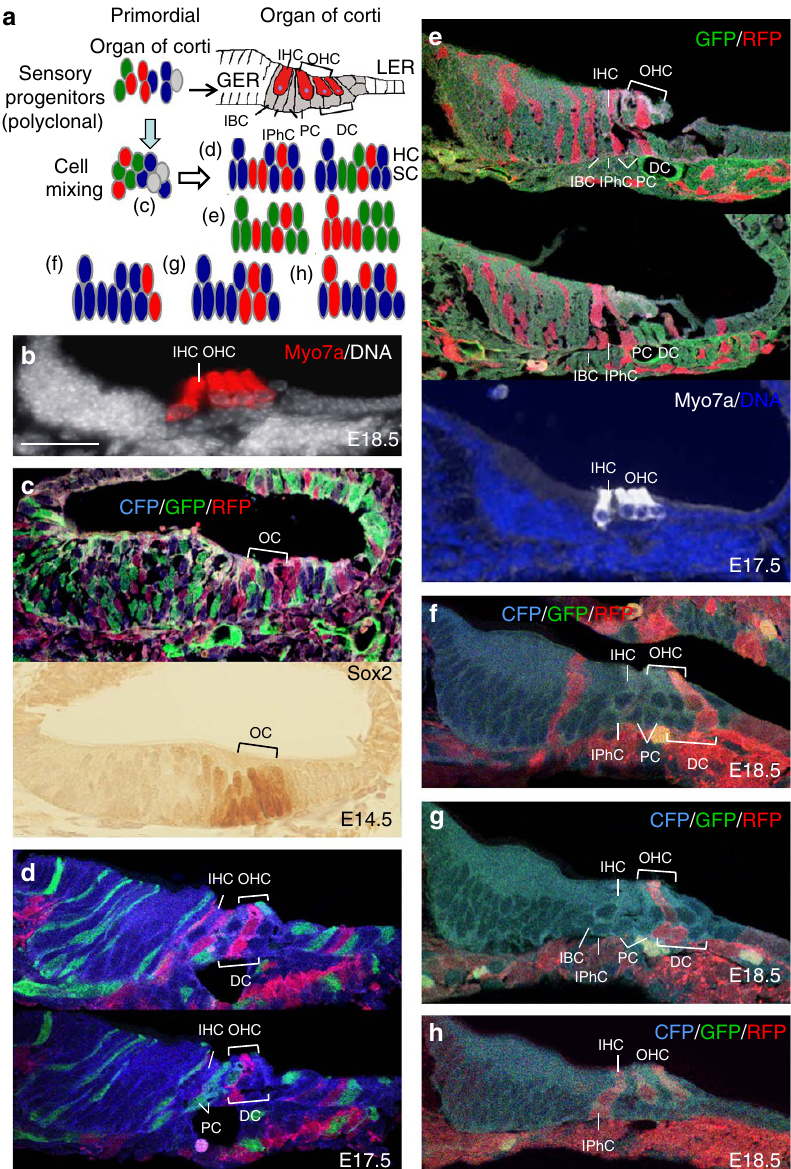
Figure 2 | Clonal analysis of tetrachimeric cochlea between E14.5 and E18.5. ( a ) Schematic of expected results of cochlear sensory organ obtained in this study. Cell types in the organ of Corti (OC): one inner hair (IHC) and three outer hair (OHC) cells are surrounded by different types of supporting cells (SC): one inner border cell (IBC), one inner phalangeal cell (IPhC); inner and outer pillar cells (PC); and three Deiters’ cells (DC). In the case where multiple putative bipotent progenitors proliferate in the prosensory domain and mix during development, it would always show a mixture of the same colour as observed in ( c ). Within the OC, if a progenitor differentiates into hair and underlying SCs, then these cells next to each other would show the same colour as indicated in ( d – h ), which illustrate the results observed in ( d – h ). ( b ) A section of E18.5 cochlea stained with Hoechst (grey) and anti-Myo7a (red). ( c ) Upper panel: Merged image of a section of chimeric cochlea at E14.5. Lower panel: an adjacent section immunostained for Sox2 in the nascent OC. ( d ) Merged images from adjacent sections of four-coloured (CFP, GFP, RFP and nonfluorescent) cochlea at E17.5. ( e ) Top panel: Merged image of a section showing GFP, RFP and nonfluorescent cochlea at E17.5. Middle panel: A merged confocal image from adjacent section showing the IHC and the IB, IPhC and PCs in red but the three OHCs and the DCs in green. Bottom panel: an adjacent section stained with anti-Myo7a (white) and Hoechst (blue). ( f ) Merged image of a section of E18.5 cochlea (injected with reduced coloured ES cells) showing the outermost OHC and underlying DC in red, while the other two OHCs and the IHC as well as other SCs uncoloured. ( g ) Merged image from a section of another cochlea of the same embryo as shown in ( e ). The middle OHC and two underlying SCs are displayed in red. ( h ) Merged image from an adjacent section of F showing the IHC and the IPhCs in red. Two red OHCs are separated by the uncoloured OHC. Scale bar: 25 m m ( b ); 50 m m ( c – g We next co-injected the mitotic tracer 5-ethynyl-2 0 - exit in an apex-to-base progression between E12.5 and deoxyurindine (EdU) with tamoxifen (2 mg) to confirm that E14.5, EdU-Alexa 350/488 antibody staining of cochlea at E18.5 marked individual cells within each single-colour clonal cluster ( n ¼ 10 cochleae) revealed that application of EdU at E12.5 are derived from a common clonogenic proliferative multipotent labelled many cells within the organ of Corti in the basal turn stem/progenitor cell. Consistent with sensory precursor cell cycle (Fig. 5a), but injection of EdU at E14.5 ( n ¼ 10 cochleae) labelled